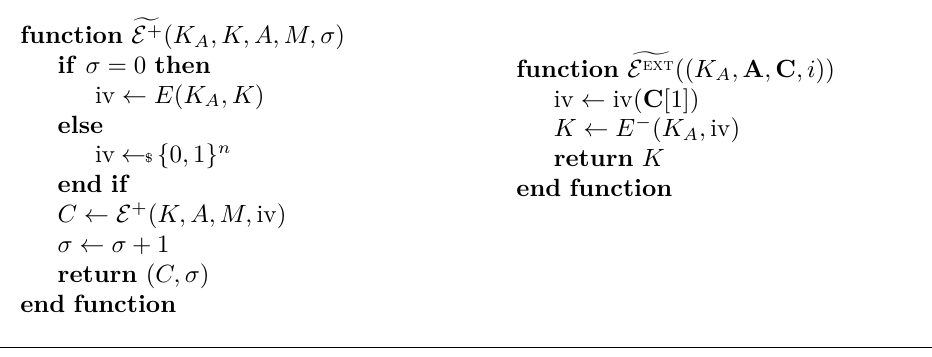
Algorithm 2.1 Pseudocode of the subversion attack from [BPR14]. Here E denotes an IV-based encryption scheme, and E is a length-preserving deterministic encryption scheme.